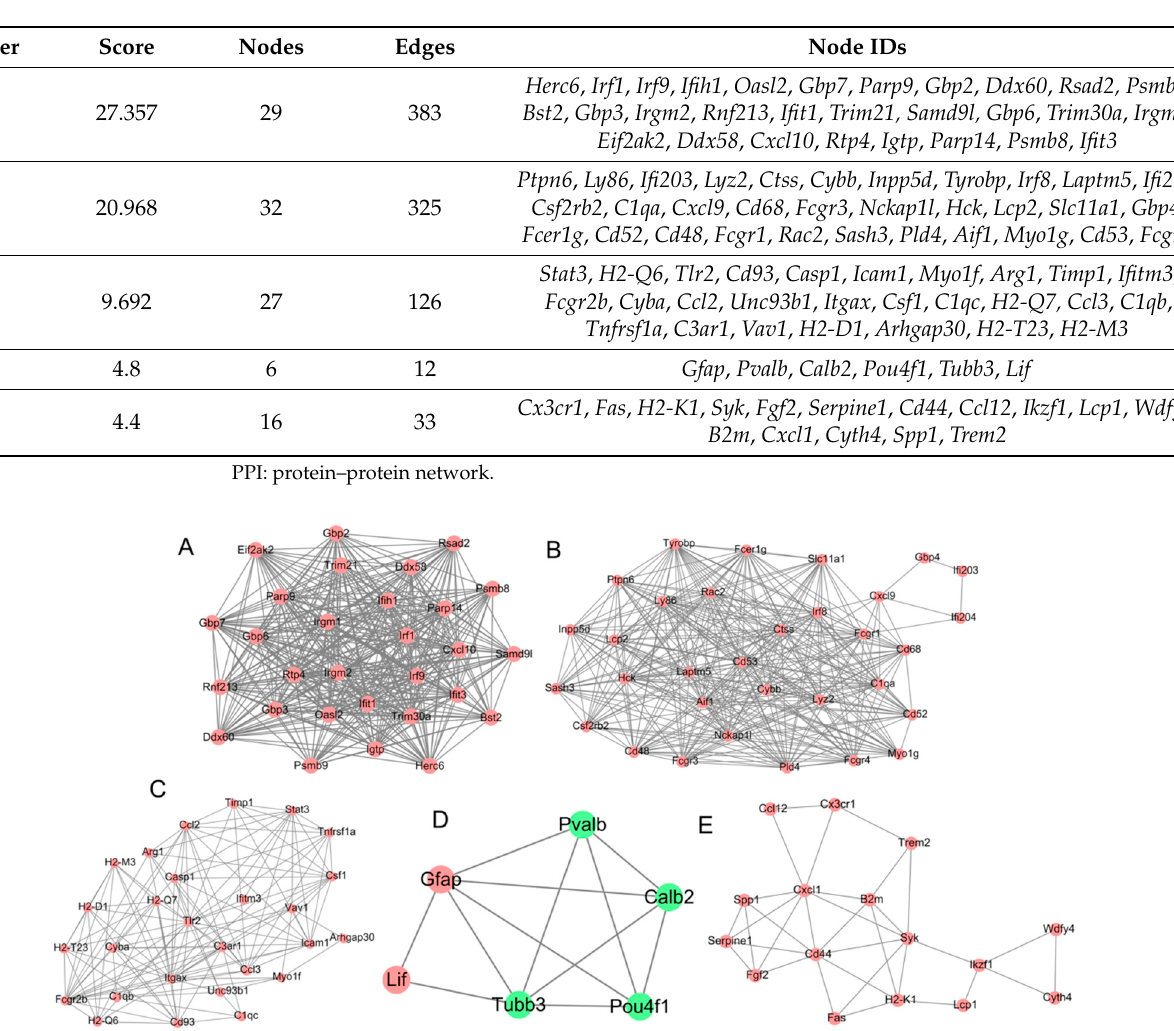
Table 5. Modules screened from the PPI network.